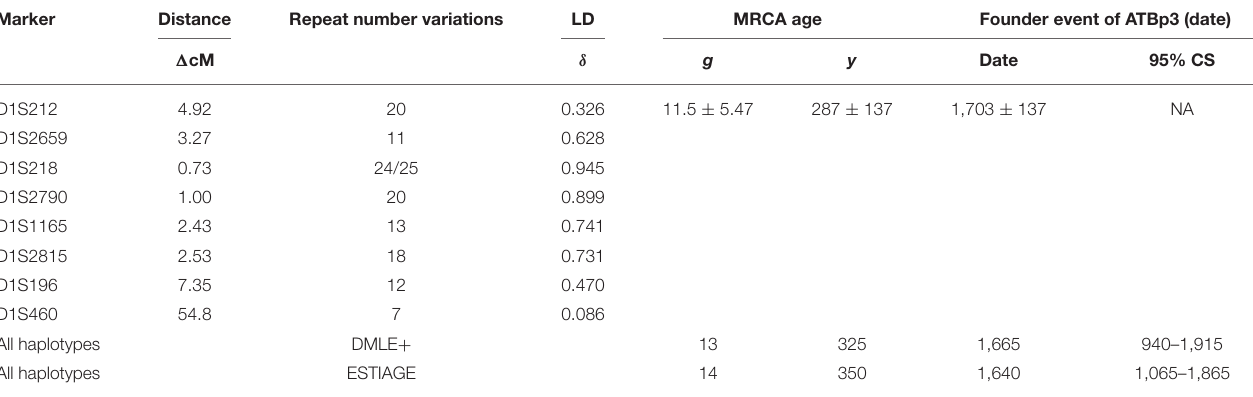
TABLE 1 | Estimation of the age of the c.391C > T mutation in the SERPINC1 gene by different methods. Marker Distance Repeat number variations LD MRCA age Founder event of ATBp3